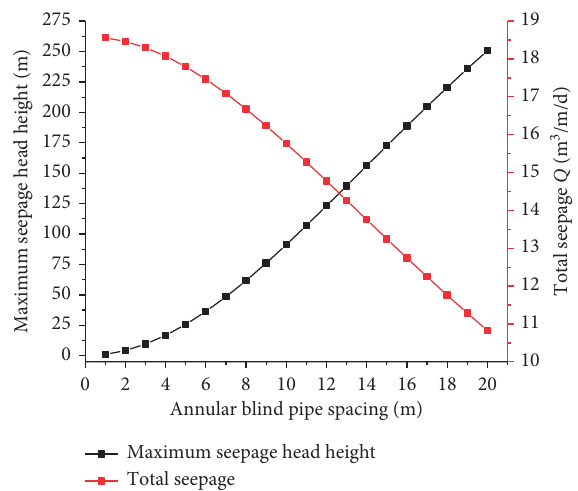
Figure 8: The curve of the relationship of the distance between the circular blind pipes, the water seepage, and the maximum head height.